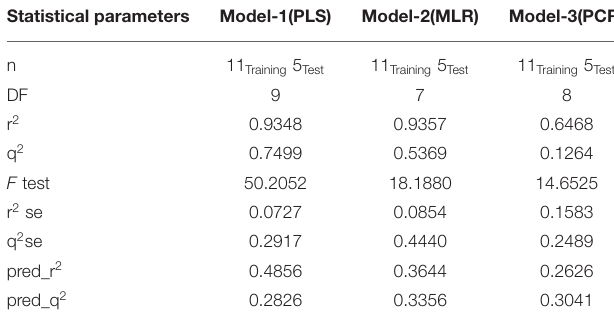
Table 3C | Statistical results of 2D-QSAR models against A. solani .